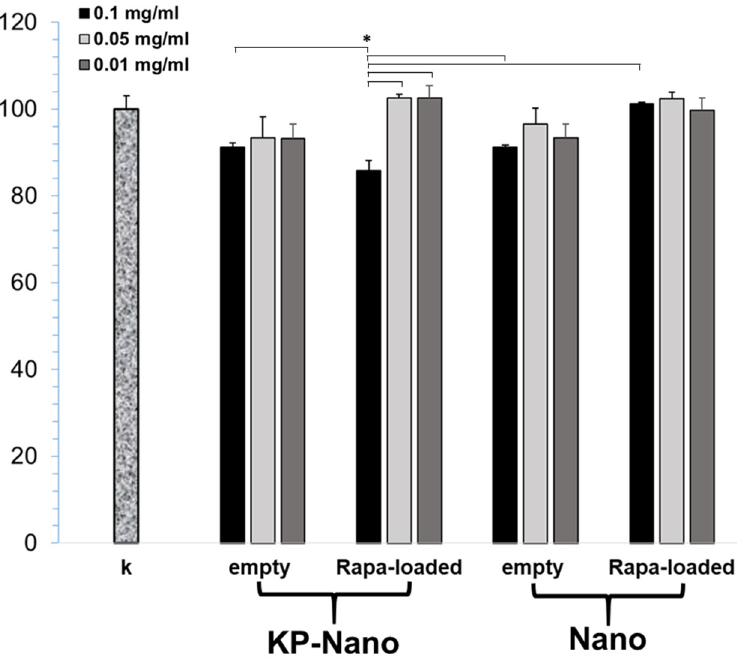
Figure 4. MTT assay of RAW264.7 cells after 24 h of incubation with Rapa loaded into KP-Nano or Nano, and empty KP-Nano or Nano. Cell viability expressed as % respect to untreated cells. (* p < 0.001).